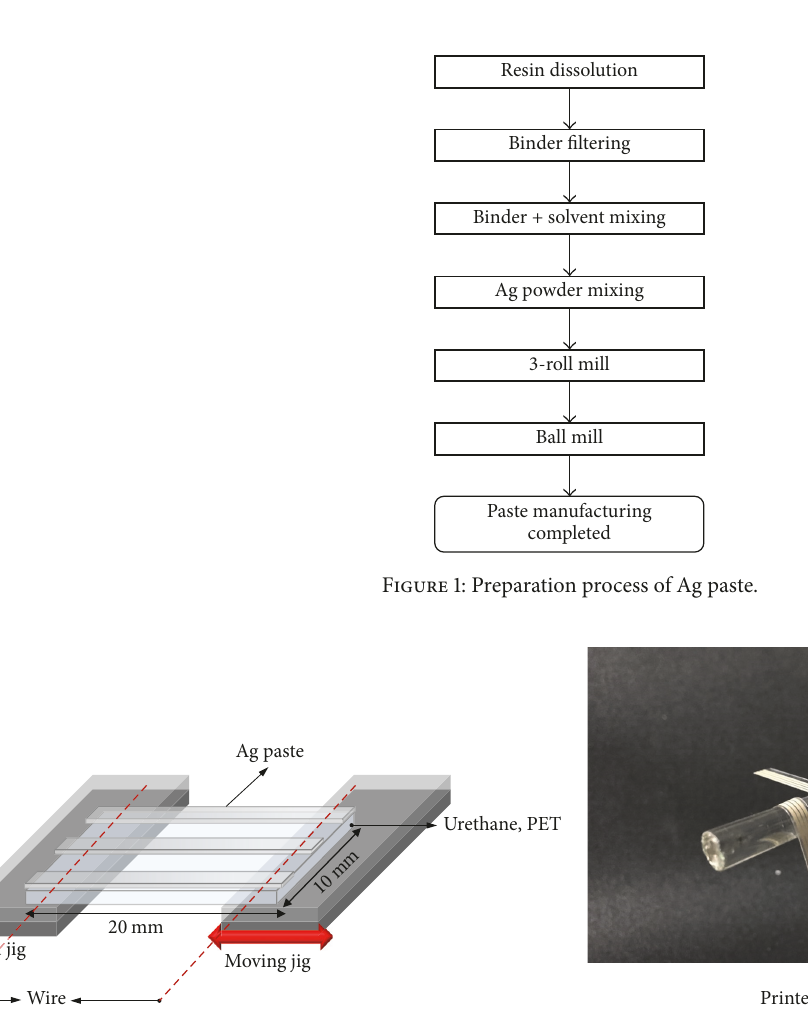
visible light transmittance in the range of